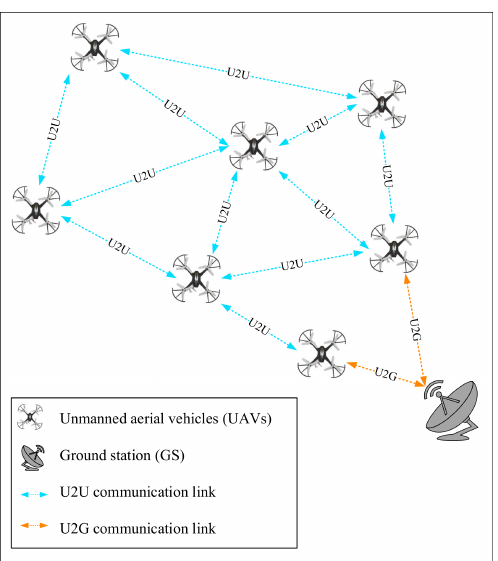
Figure 2. Various types of communication in the flying ad hoc network.